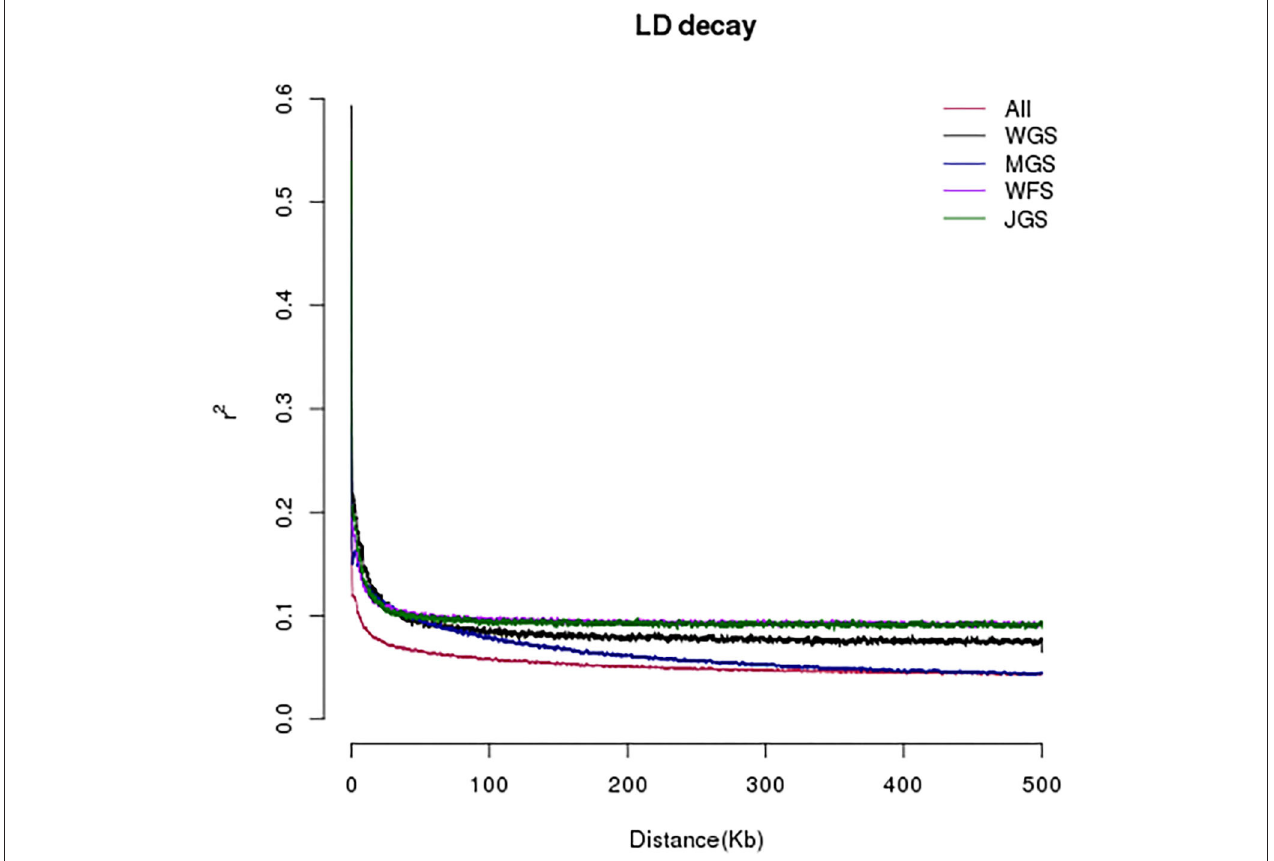
FIGURE 3 | Model of linkage disequilibrium (LD) decay of the 143 male Actinidia eriantha